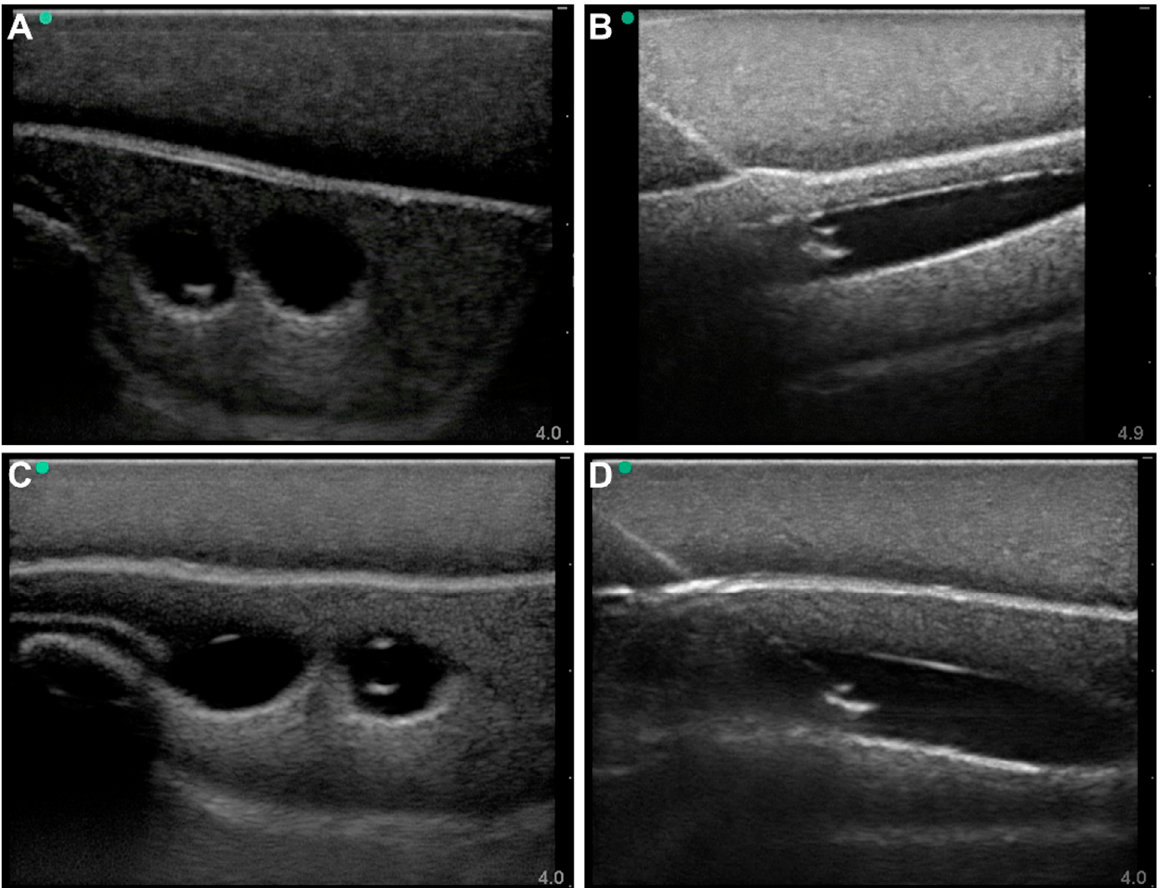
Figure 3. Commercially Available Simulab Regional Anesthesia Femoral Trainer with SmarTissue System Vascular Access Model. Out-of-plane ( A ) and in-plane ( B ) views of arterial needle insertion and out-of-plane ( C ) and in-plane ( D ) views of venous needle insertion.